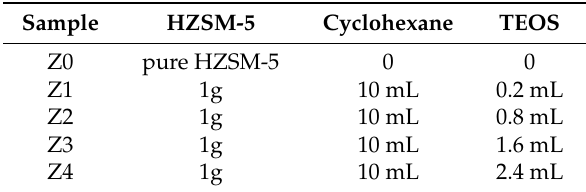
Table 1. The component ratios of as-prepared